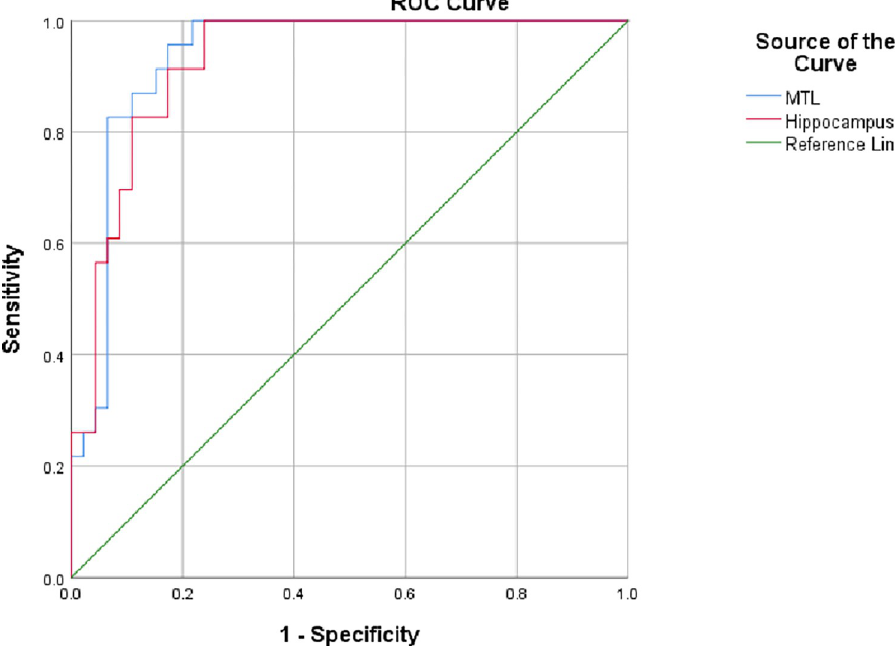
Fig 5. The ROC curves and their areas under the ROC curves for the total MTL and hippocampal volumes for the detection of Alzheimer’s